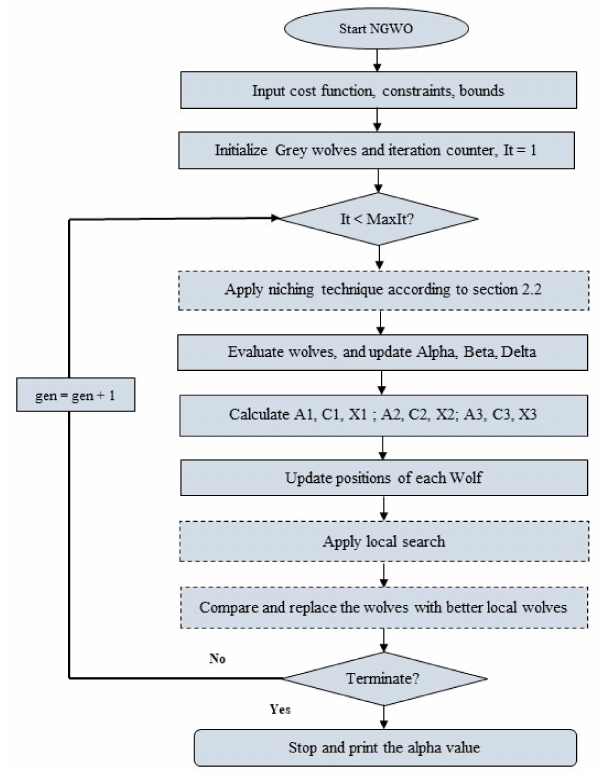
Figure 1. Steps of the NGWO